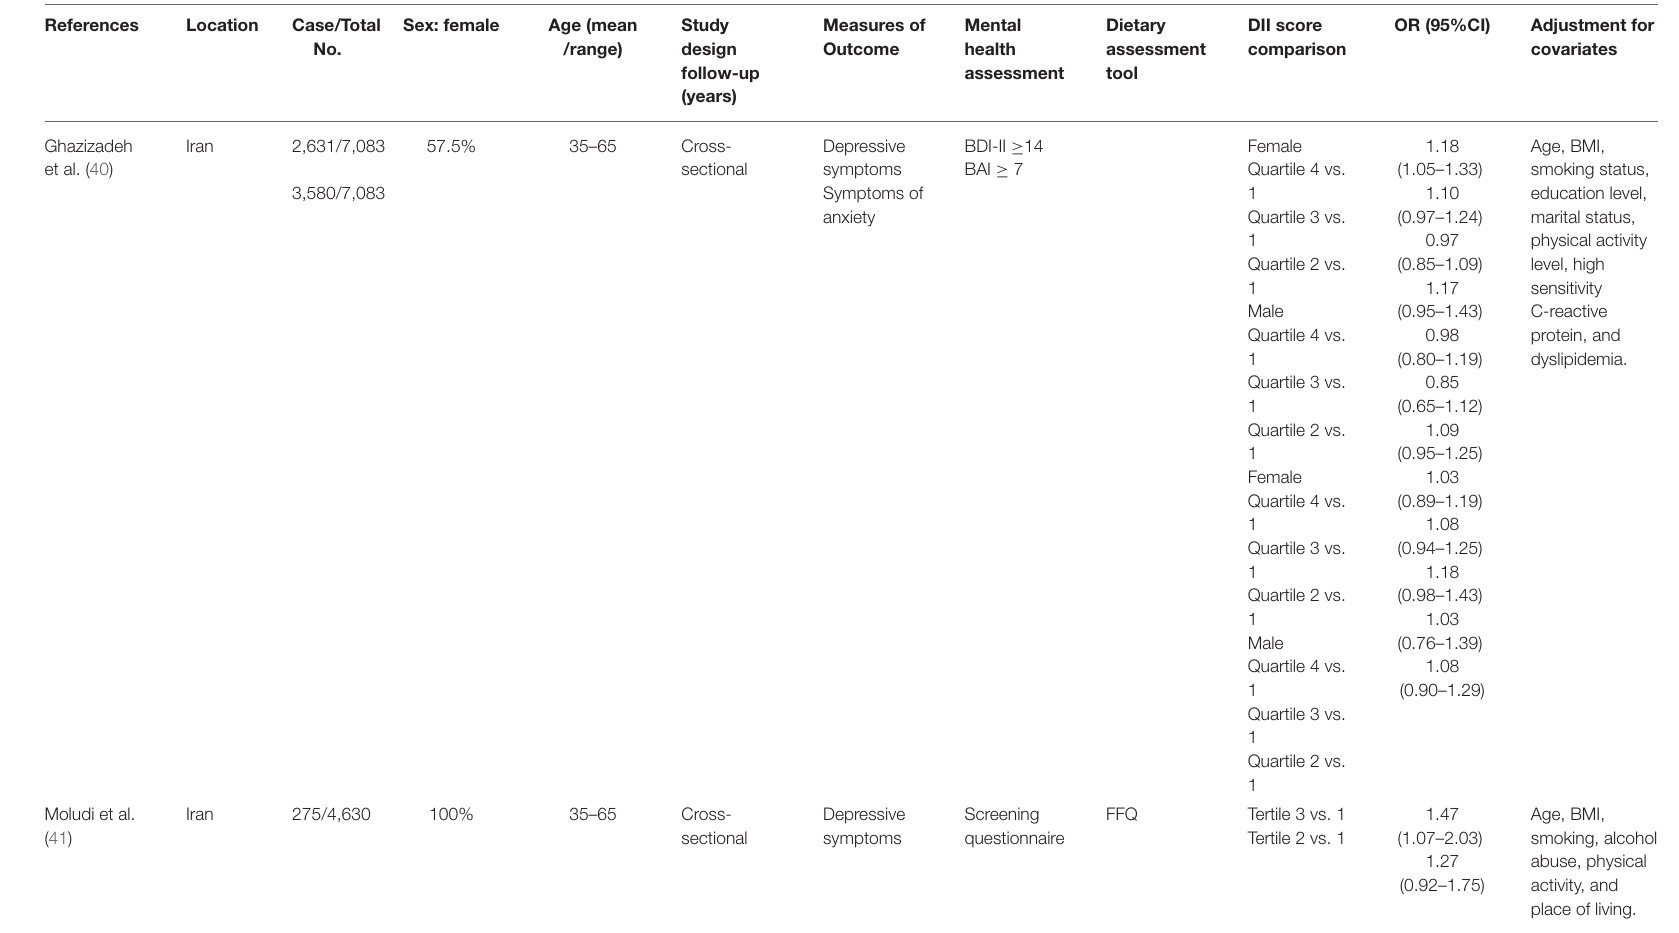
FFQ, Food frequency questionnaire; CES-D, Center for Epidemiologic Studies Depression Scale; HRQOL, Health-Related Quality of Life; GHQ, General Health Questionnaire; HADS, Hospital Anxiety and Depression Scale; PHQ-9, Patient Health Questionnaire-9; DASS, Depression Anxiety and Stress Scale; ICD-10, International Statistical Classification of Diseases-10; BDI-II, Beck Depression Inventory II; BAI, Beck Anxiety